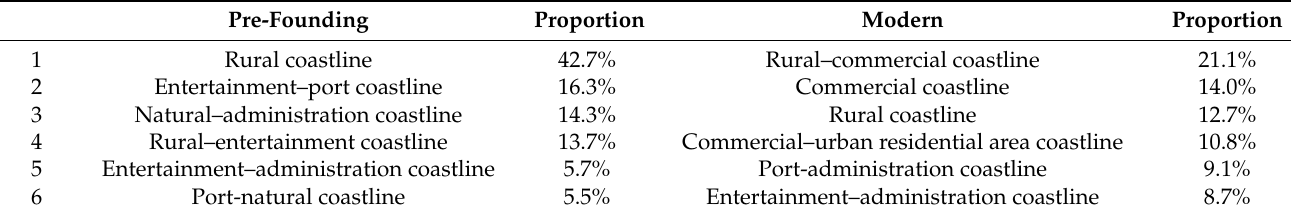
Table 6. Coastline type proportion changes between the pre-founding simulated coastline and the modern simulated coastline in